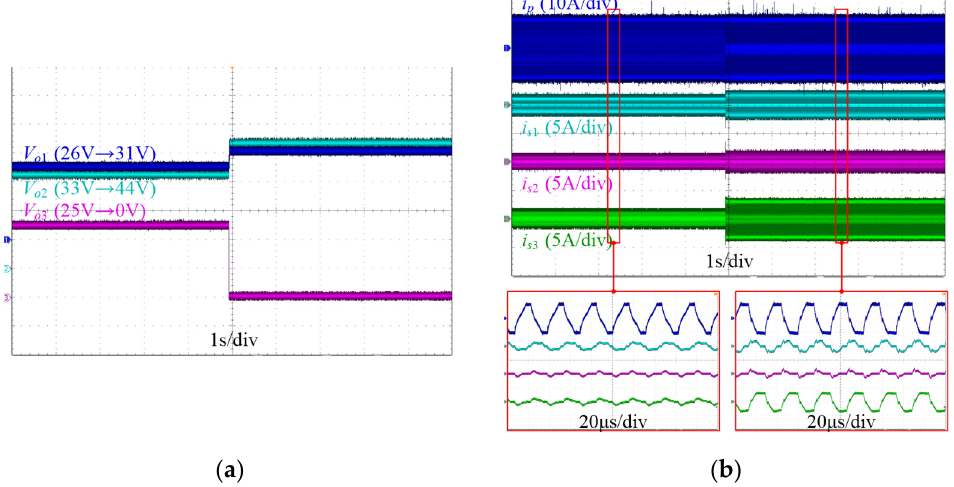
Figure 16. Experimental waveforms under short-circuit conditions. ( a ) Waveforms of the output voltages. ( b ) Waveforms of the current transformers.